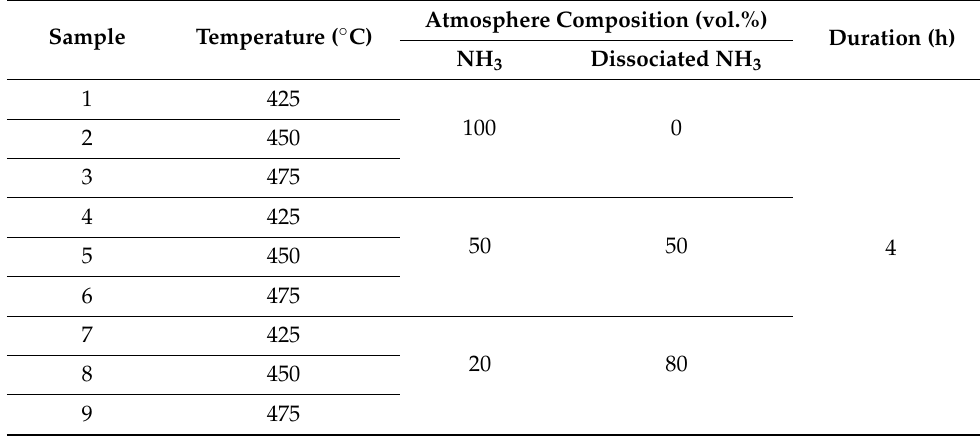
Table 3. Nitriding parameters used in the experiment and sample